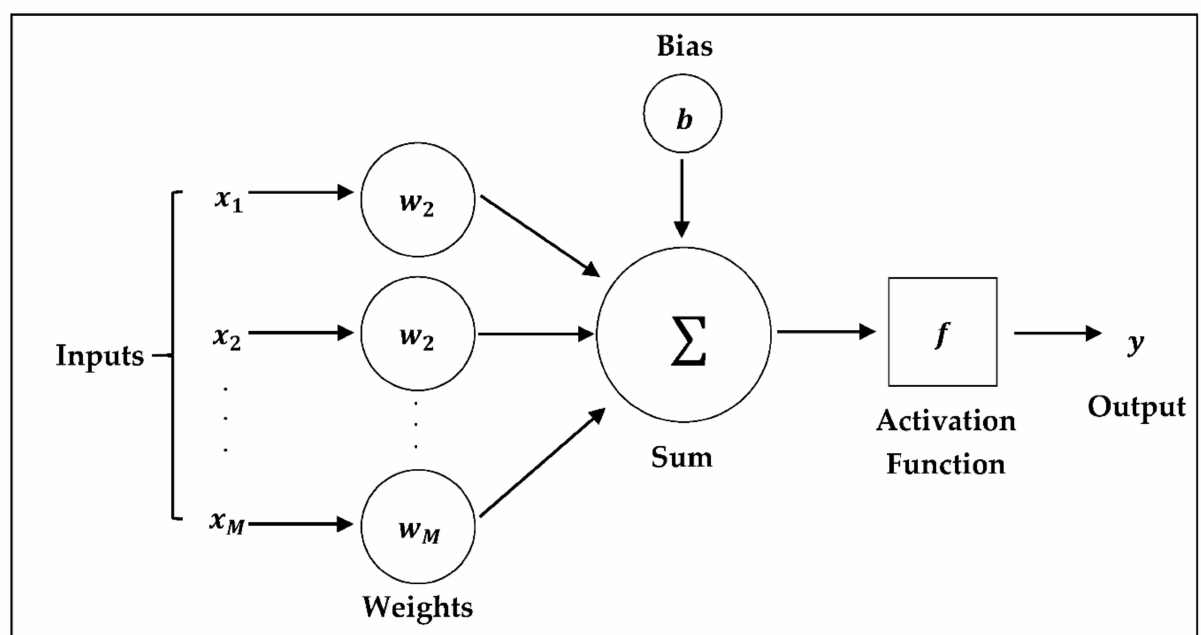
Figure 3. An example of an artificial neuron and its basic characteristics. The next step involved the selection of the optimum number of neurons in the hidden layer. The FFNN consists of three layers, the input, hidden and output layers [58]. The number of neurons in the input and output layers is completely determined by the inputs and outputs. The hidden layer size is an important part of the network architecture. In order to select the optimum architecture, the criterion that was followed was the minimization of the Mean Absolute Error (MAE) on the validation subset [59]. Lower MAE values correspond to a better performing network in relation to a lower degree of